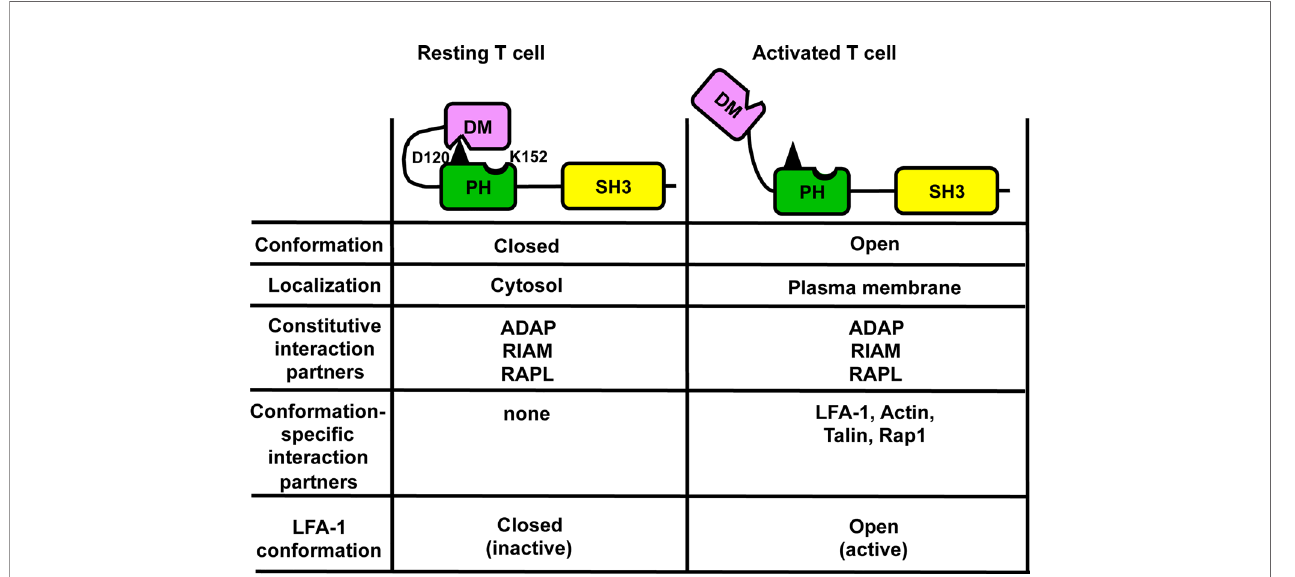
FIGURE 3 | Auto-inhibition model of SKAP1 that controls targeting of SKAP1 to the plasma membrane. In resting T cells, SKAP1 is in a closed (auto-inhibited) conformation where aspartic acid 120 (D120; depicted in black) within PH domain mediates an interaction with the DM domain (DM-PH). In this conformation, SKAP1 is localized in the cytoplasm and is constitutively associated with ADAP, RAPL and RIAM. In TCR/CD3 -stimulated T cells, the DM-PH interaction is released by an unknown mechanism to stabilize the open (active) conformation, which enables recruitment of the constitutive interaction partners (ADAP, RAPL and RIAM) of SKAP1 to the plasma membrane. The now accessible lysine 152 (K152) within in the PH domain of SKAP1 inducible interacts with actin and promotes Rap1/Talin binding to RIAM and to LFA-1. Under these conditions LFA-1 is in an open conformation to facilitate